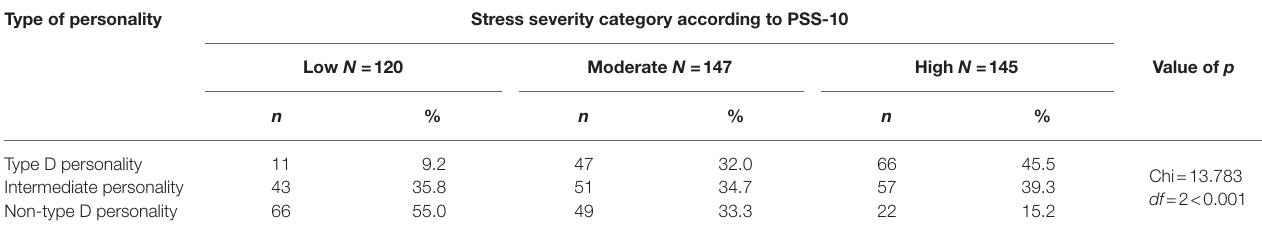
TABLE 3 | Severity of stress depending on the personality type in surveyed